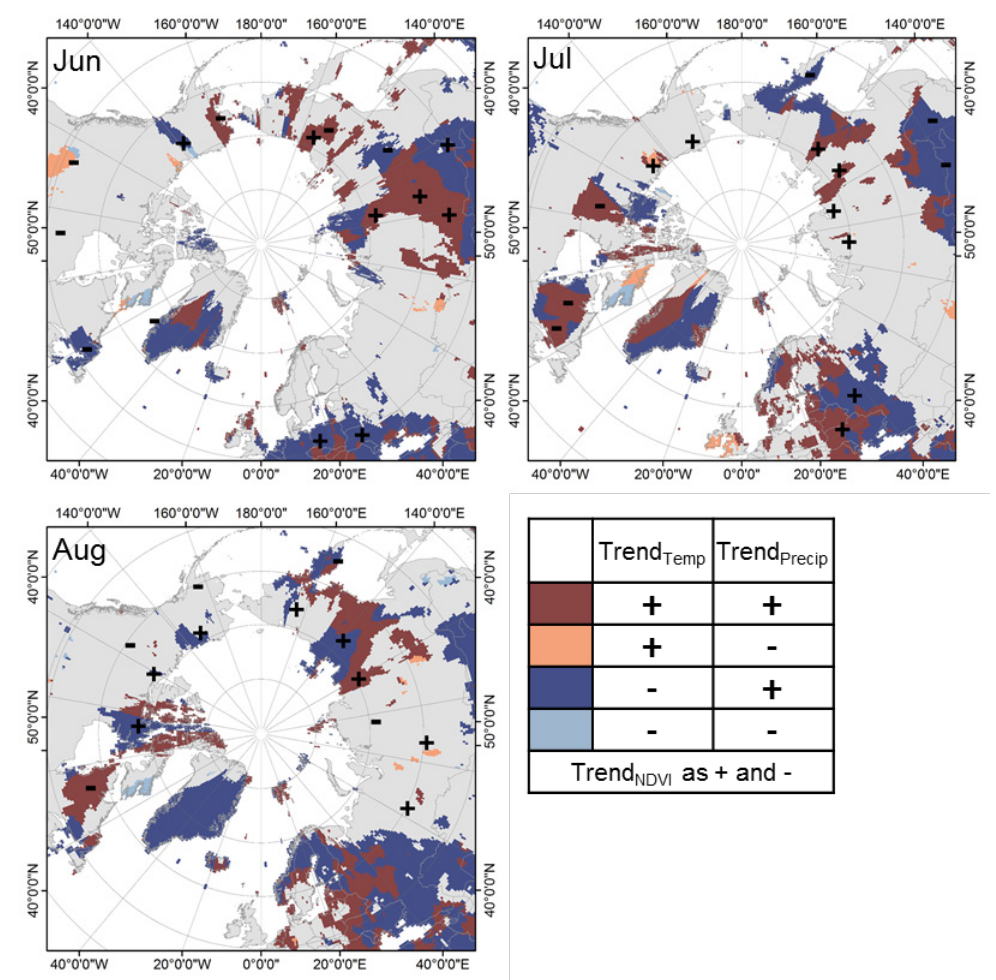
Figure 3. Co-occurrence of different climatic and ecosystem trends on pan-arctic scale between 1981 and 2012 (June to August). The trend findings from monthly temperatures and precipitation were combined into one information source. The NDVI is shown via plus or minus symbols, which are indicating either positive or negative trends at the